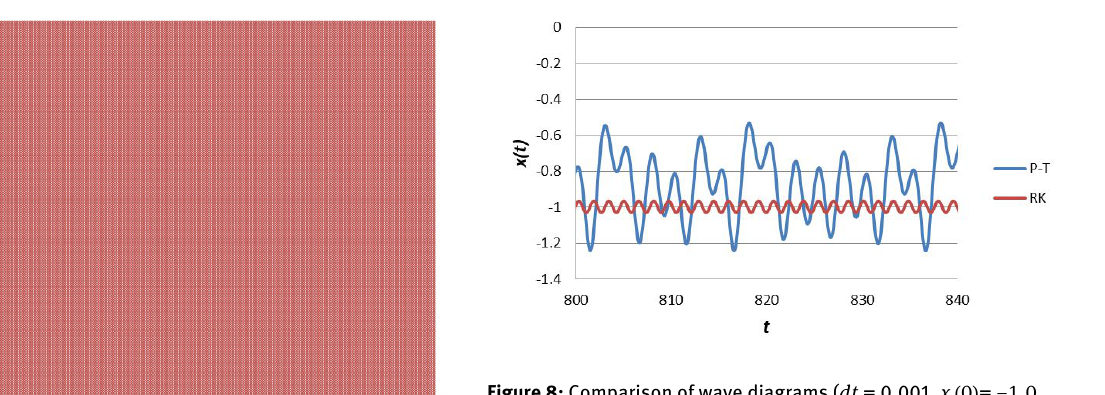
Figure 8: Comparison of wave diagrams ( dt = 0.001, x (0) = −1.0 , ˙ x (0) = −1.0 )